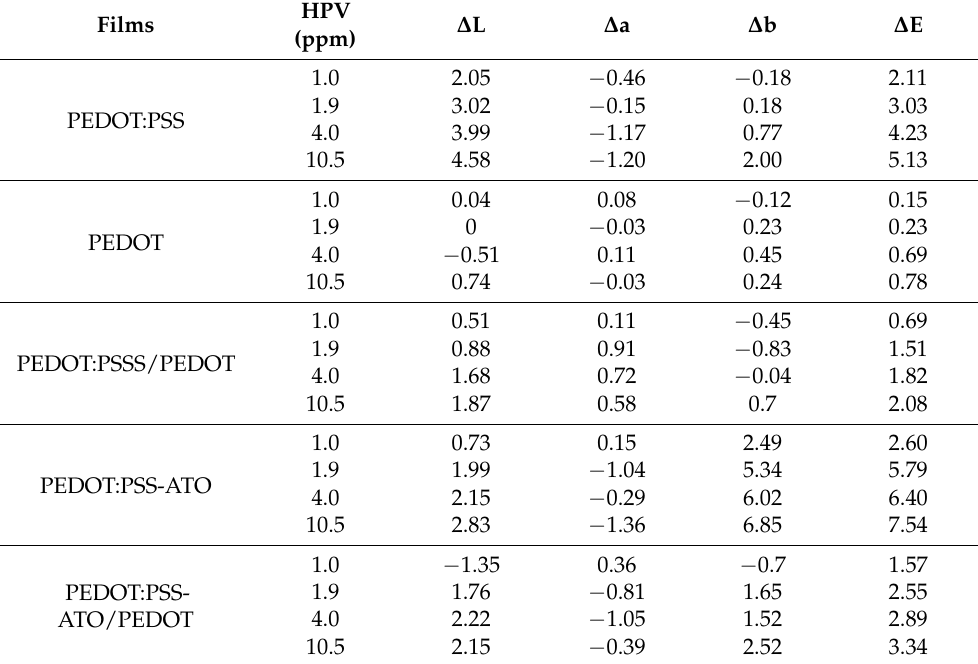
Table 2. Colorimetric response results of PEDOT:PSS, PEDOT, PEDOT:PSS/PEDOT, PEDOT:PSS- ATO, and PEDOT:PSS-ATO/PEDOT films under different concentrations of